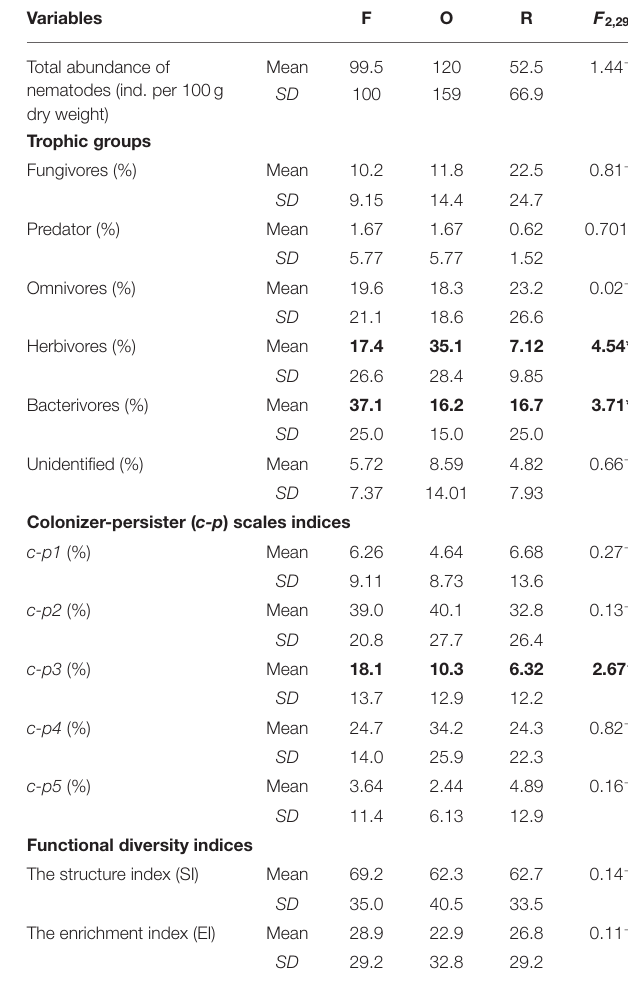
TABLE 2 | Mean, SD, and F - and p -values for land use and riparian sites in litter. Variables F O R F 2,29 Total abundance of nematodes (ind. per 100g